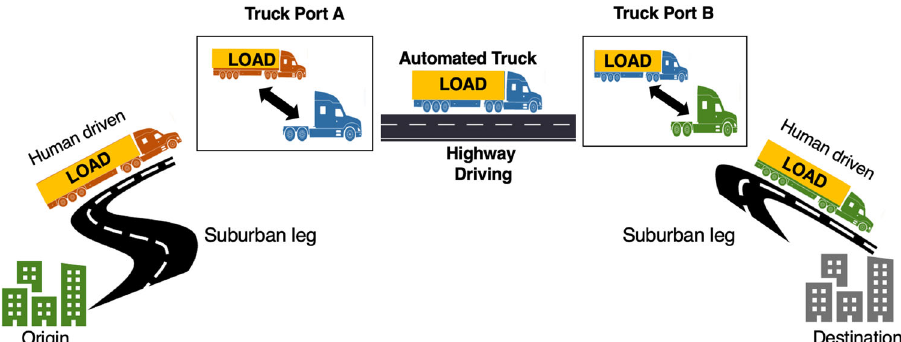
Fig. 1 Schematic showing the possible operation of a transfer-hub model where a human driven truck drives the load from the origin to the fi rst truck port where the load is switched to an automated prime mover shown in black. This completes the highway leg of the journey to another truck port where a human driven truck takes the load from the port to the fi nal